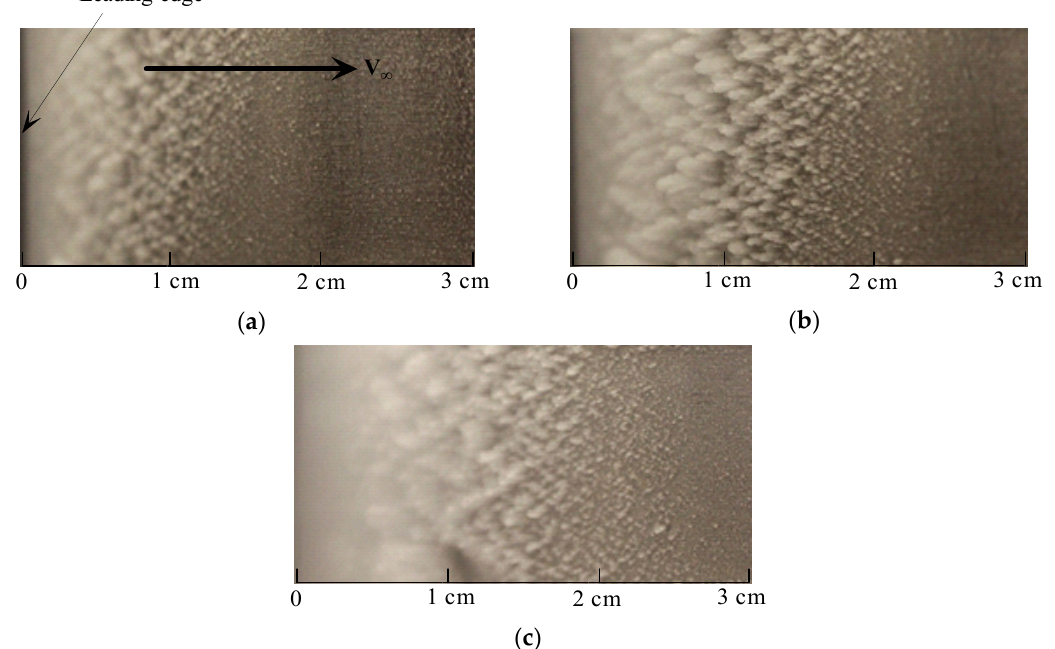
Figure 9. Experimental results of the water droplet impinging limits: ( a ) Case 1; ( b ) Case 2; ( c ) Case 3.